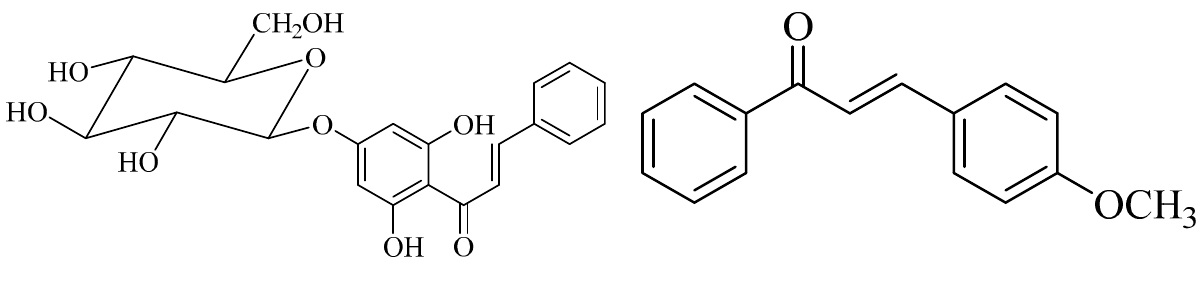
Figure 4. Structures of the main chalcone ( 1 ), ( 2 ).